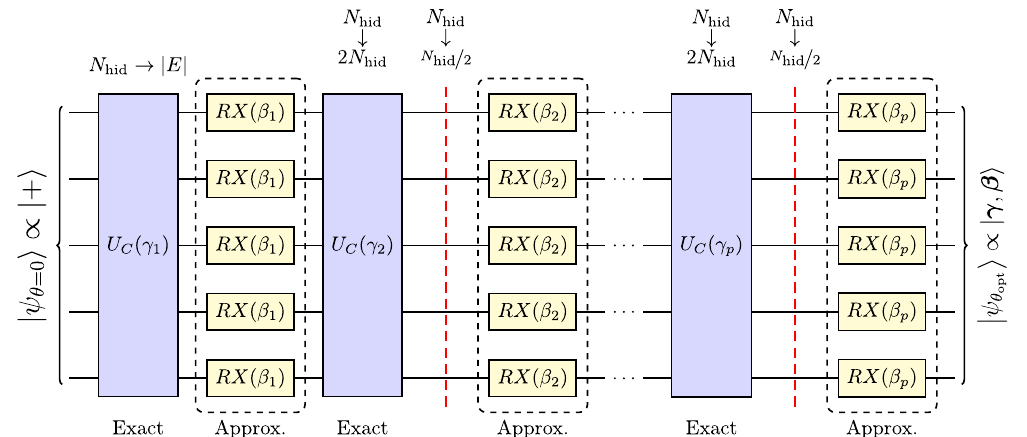
Fig. 1 The QAOA quantum circuit. A schematic representation of the QAOA circuit and our approach to simulating it. The input state is trivially initialized to þj i . Next, at each p , the exchange of exactly ( U C ) and approximately ( RX ( β ) = e − i β X ) applicable gates is labeled (see Sec. Methods). As noted in the main text, each (exact) application of the U C gate leads to an increase in the number of hidden units by ∣ E ∣ (the number of edges in the graph). In order to keep that number constant, we "compress" the model (see Sec. Methods), indicated by red dashed lines after each U C gate. The compression is repeated at each layer after the fi rst, halving the number of hidden units each time, immediately after doubling it with U C gates. After the fi nal layer, the RBM is parametrized by θ opt , approximating the fi nal QAOA target state γ ; β j